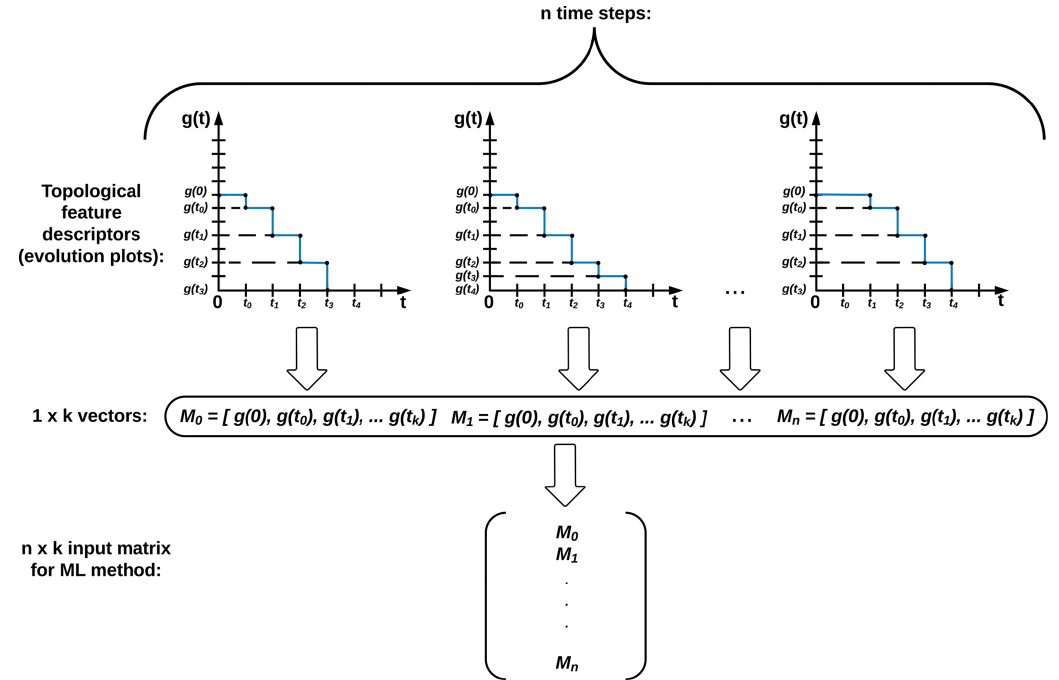
Figure 6. Creating an input matrix for the machine learning method: the mapped evolution plots into 1 × k vectors (topological feature descriptors) are stacked on top of each other to construct n × k input matrix for the SVM classifier. The matrix is used by the SVM (see